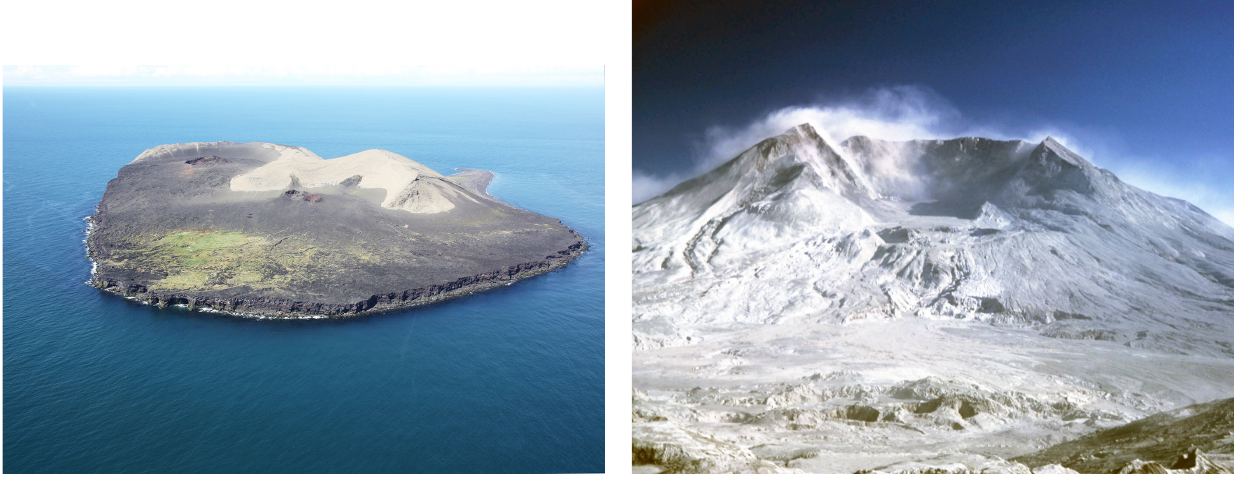
Fig. 1. (A) Surtsey: aerial view looking north showing the barren tephra hills, crater areas and protruding sand spit. The descending lava shield with the dense vegetation of the seabird colony is in the foreground (Photo: Erling Ólafsson, 2010). (B) Mount St. Helens: aerial view looking south from ca. 15km north of the crater overlooking Spirit Lake and showing the devastated habitats (Photo: RdM, August 1980). The Pumice Plain is in the center; Studebaker Ridge is on the extreme right (west) of image.